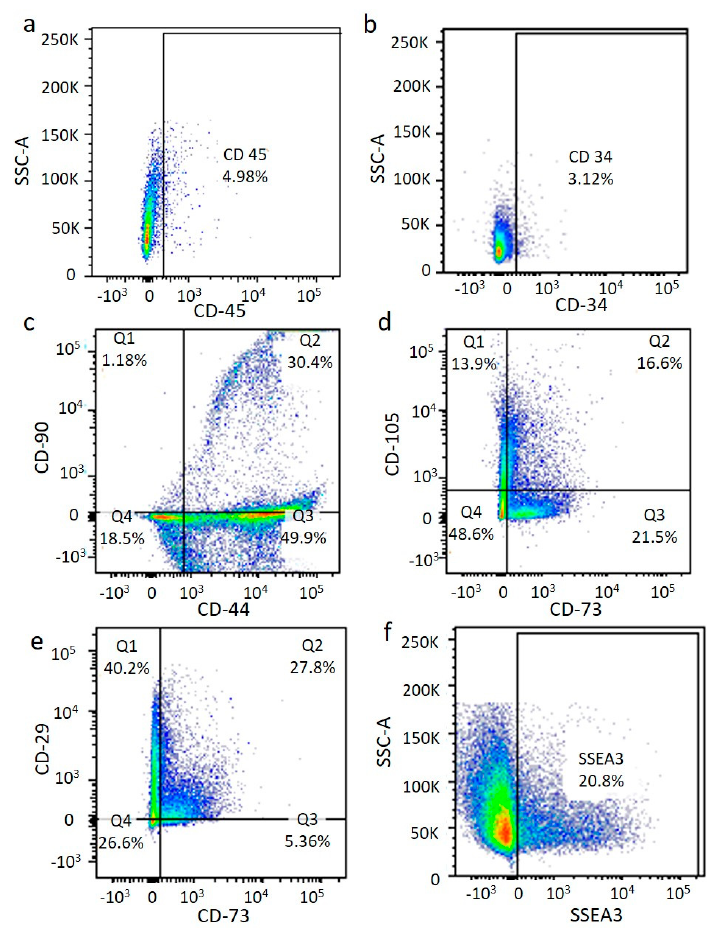
Figure 7. Flow cytometry after Rigenera ® treatment. Immunophenotyping analysis of ASCs at p 0 from Rigenera ® treatment. The presence of the ASC phenotype is confirmed. Cell markers CD45 ( a ), CD34 ( b ), CD44 / CD90 ( c ), CD73 / CD105 ( d ), CD73 / CD29 ( e ), and SSEA3 ( f